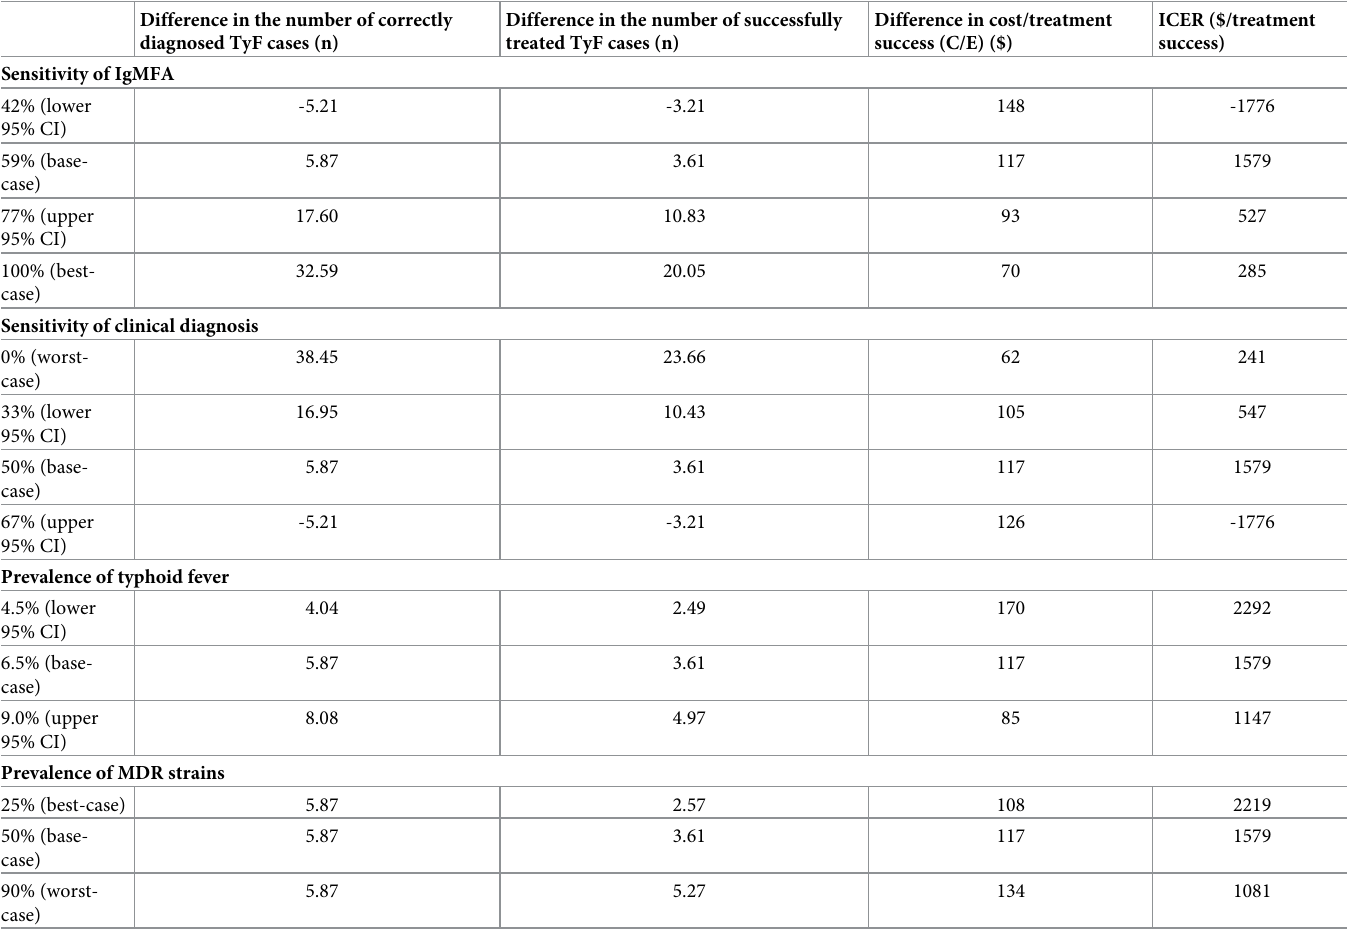
95% CI, 95% confidence interval; ICER, Incremental Cost-effectiveness Ratio; TyF, Typhoid fever. C/E (Cost-effectiveness Ratio) was derived from (costs)/(produced health effects). Difference was derived from (Effect or cost or C/E of IgMFA)-(Effect or cost or C/E of clinical diagnosis). ICER was derived from (Cost of